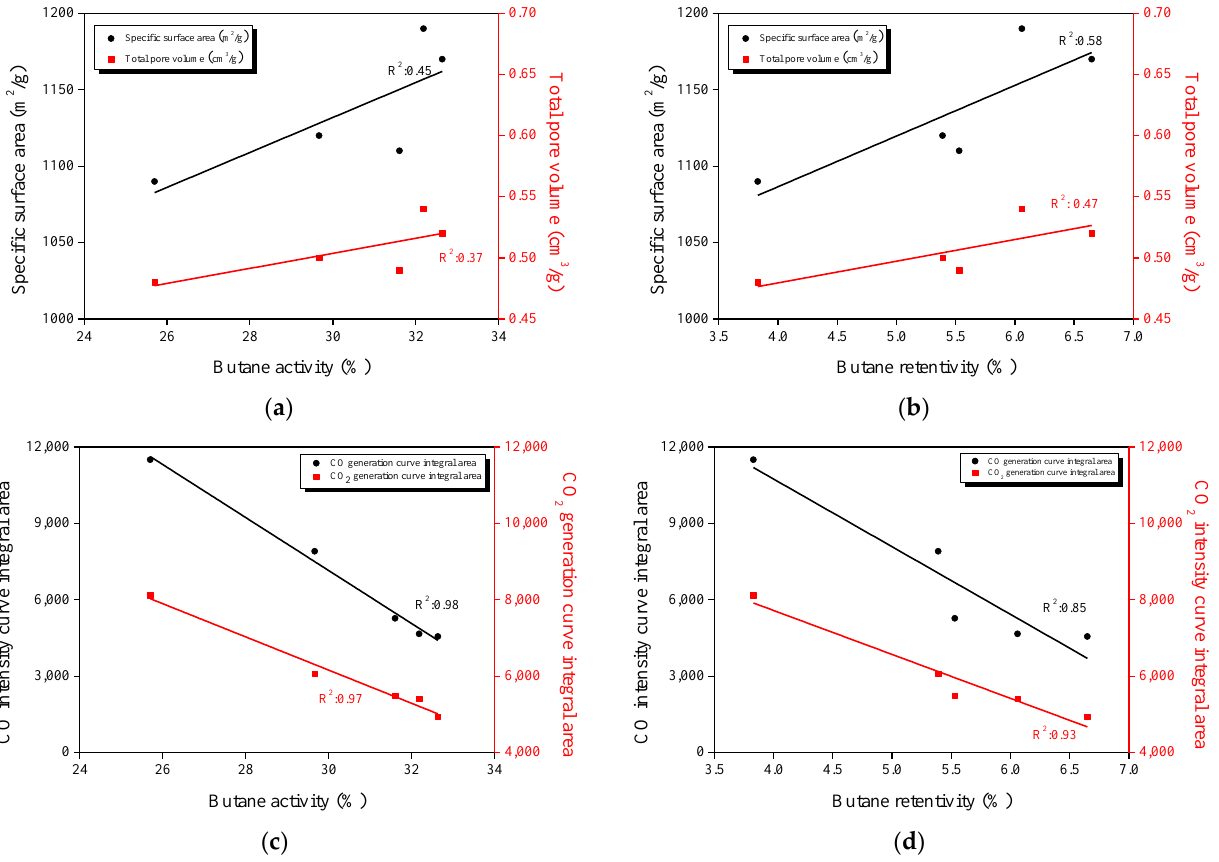
Figure 6. Correlations between the butane activity with the specific surface area and total pore volume ( a ); butane retentivity with specific surface and total pore volume ( b ); butane activity with a CO and CO 2 intensity curve integral area ( c ); butane retentivity with a CO and CO 2 intensity curve integral area ( d ).